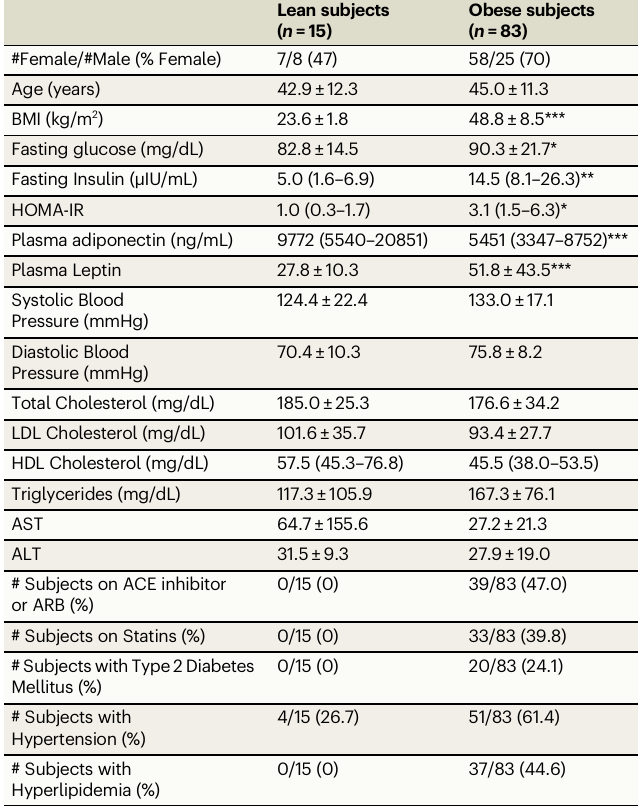
Table 1 | Demographics and Clinical Characteristics of Lean and Obese